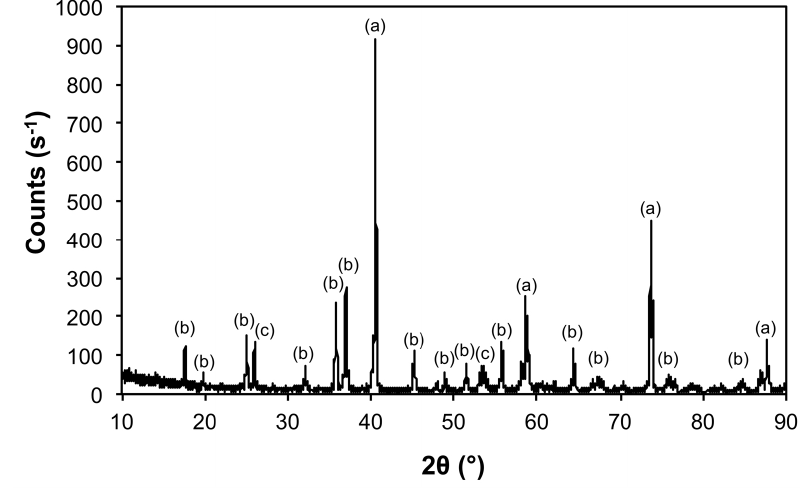
Figure 5. X-ray diffraction (XRD) of the products from the thermal decomposition of 1 under Ar at 1100 °C (Ar@1100) with crystalline phases (Table 3) indicated: (a) Mo, (b) Mo 3 Fe 3 O 8 , and (c) MoO 2 .